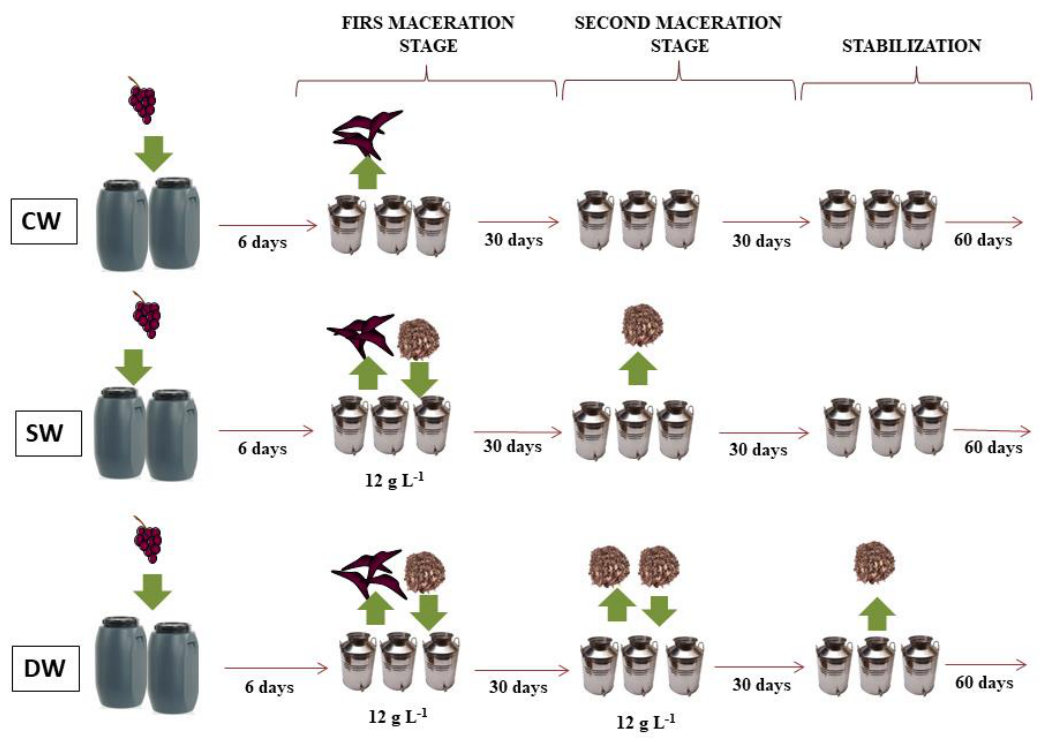
Figure 2. Schematic representation of the wine elaboration process.